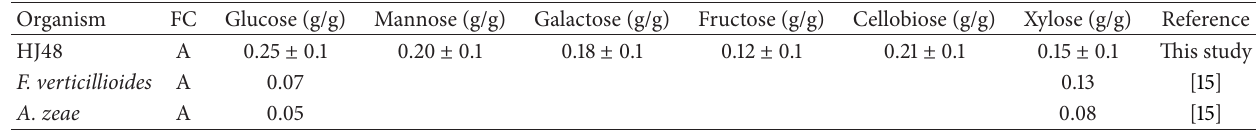
Table 4: Fungus producing ethanol from sugar directly.